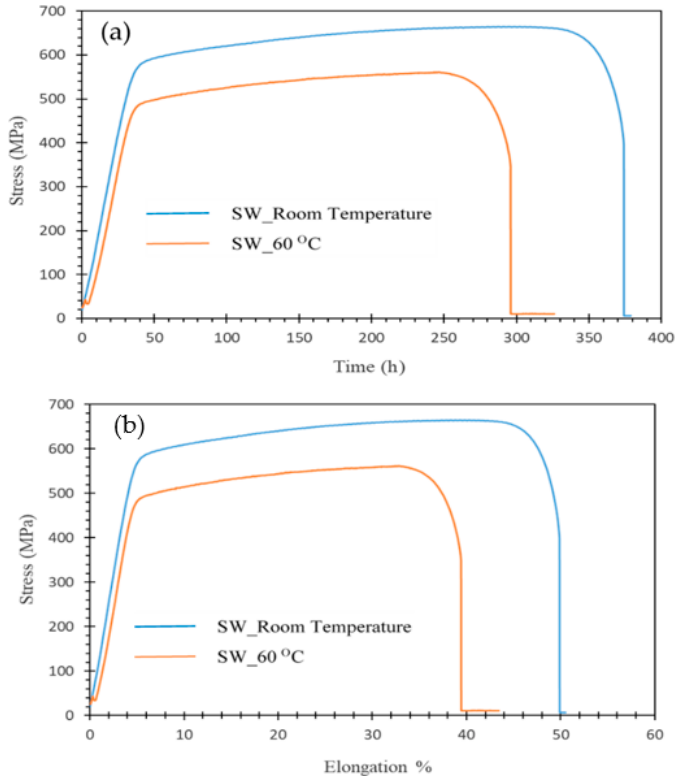
Figure 2. ( a ) Stress vs. time, and ( b ) stress vs. elongation plots of AISI 316 stainless steel alloy at strain rate of 3.7 × 10 − 7 s − 1 in the simulated SW solution at room temperature (25 °C) and 60 °C.